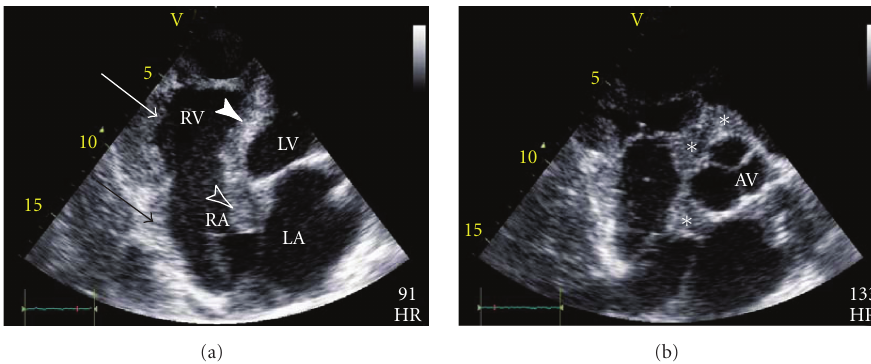
Figure 2: Apical two-dimensional four-chamber (a) echocardiogram showing marked thickening of the right ventricle (arrow), right atrium (empty arrow), interatrial septum (empty arrowhead), and basal to mid interventricular septum (arrowhead) associated with a pericardial e ff usion. Aortic valve short-axis view (b) demonstrating that the thickened tissue (asterisk) extends around the root of aorta. RA indicates right atrium; LA, left atrium; RV, right ventricle; LV, left ventricle; AV, aortic